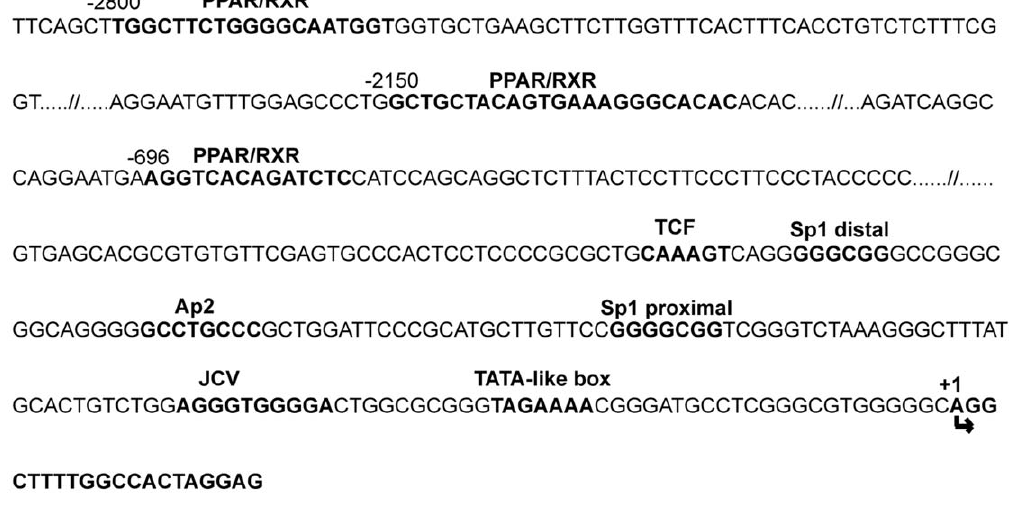
Figure 1. Putative PPAR consensus sites in the human megalin promoter. Nucleotide numbering is labeled relative to the transcription start site (nt + 1, arrow). Putative PPAR responsive-elements (PPREs) were located by MatInspector (www.genomatix.de).